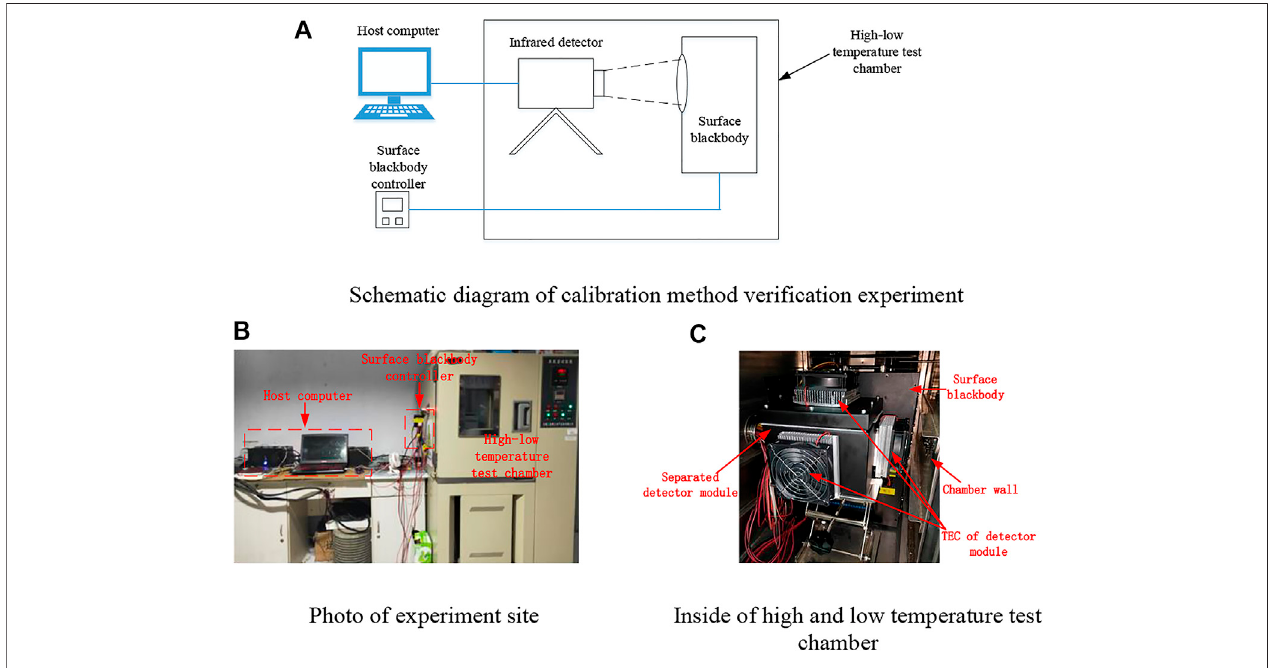
FIGURE 2 | Schematic diagram and photos of calibration method veri fi cation experiment.